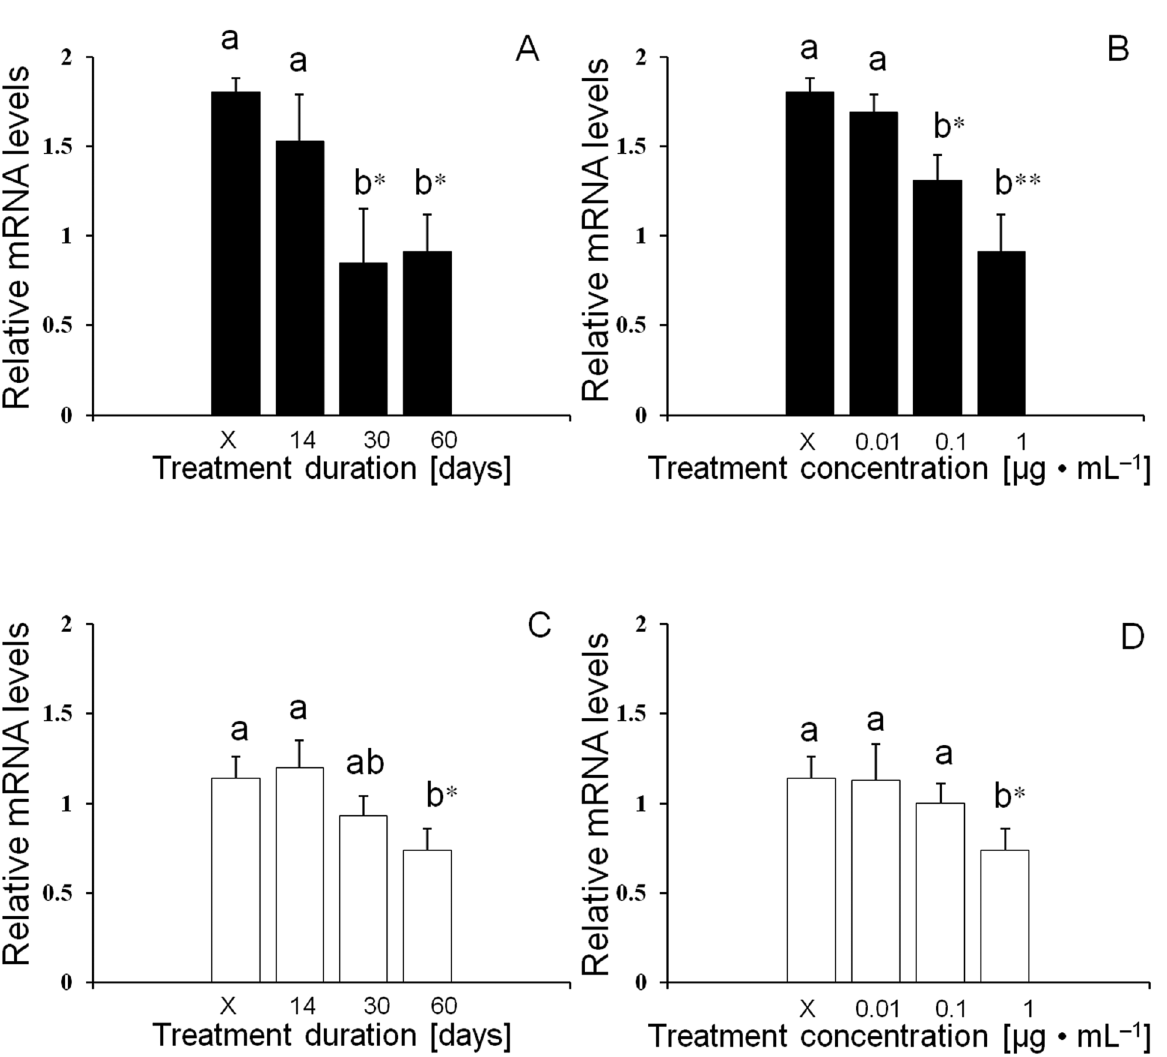
Fig. 2. Time- ( A , C ) and concentration-dependent ( B , D ) effects of pendimethalin on androgen receptor ( AR ) mRNA expression level in the dorsal fins of male ( A , B ) and female ( C , D ) Thai medaka, Oryzias minutillus , as examined by a semi-quantitative RT-PCR; X = control groups (were treated with dimethyl sulfoxide); The expression levels in each sample are relative values compared to those of β -actin mRNA (mean + SE). Dissimilar letters indicate significant dif- ferences (one-way ANOVA with Tukey’s multiple comparison test; * = P < 0.05 and ** = P < 0.01,